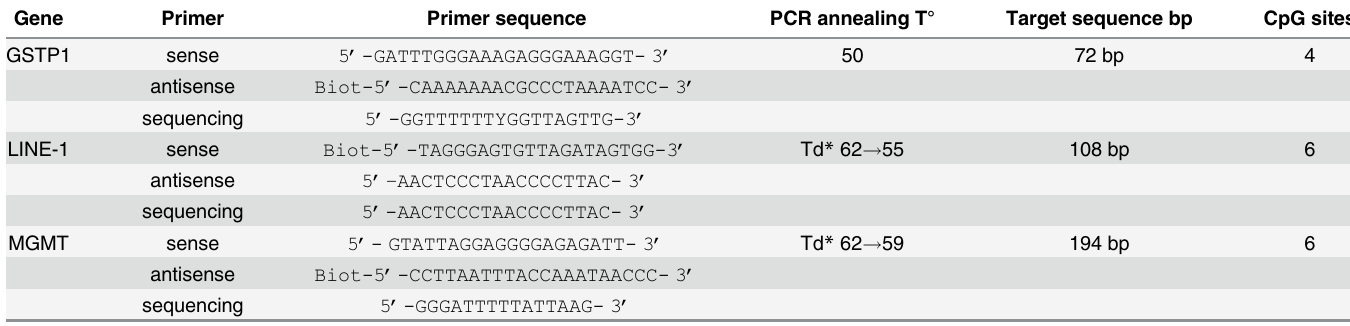
Table 1. Pyrosequencing primer sequences and annealing